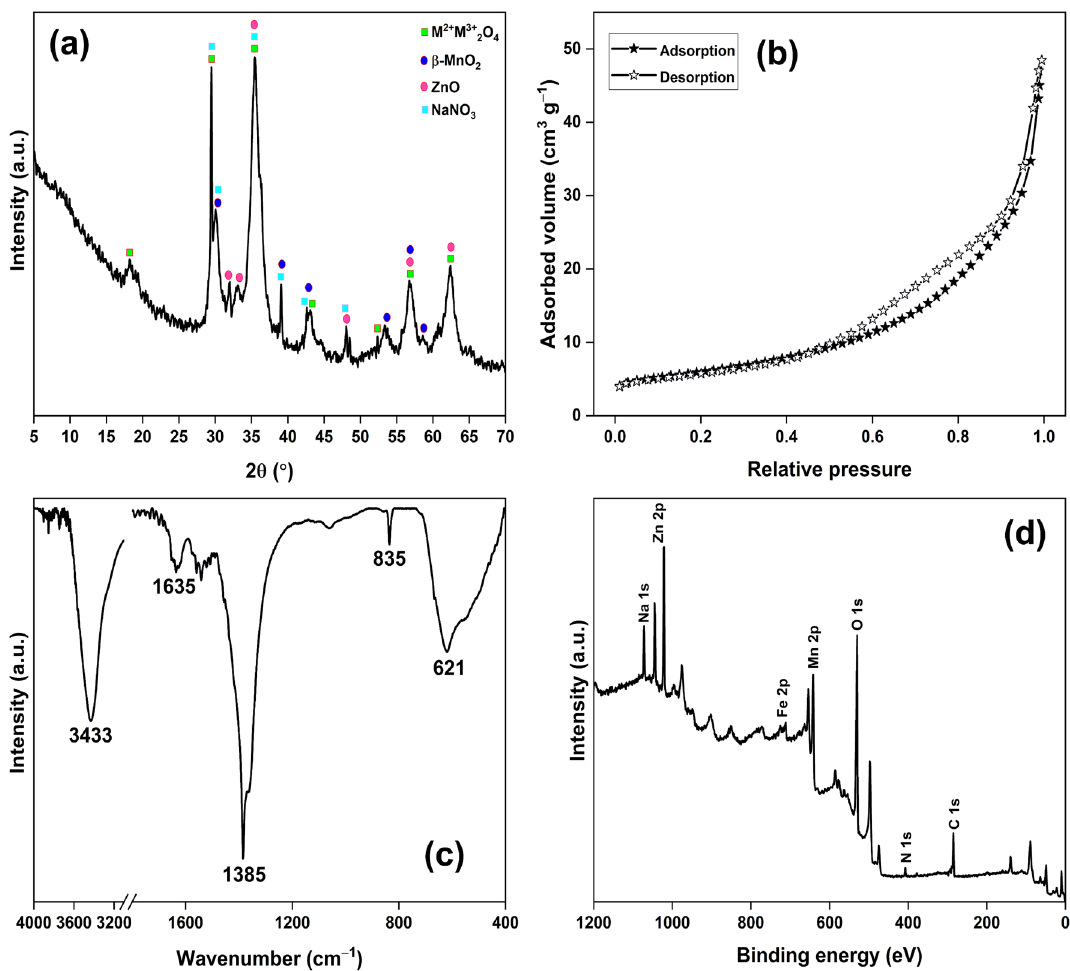
Figure 2. ( a ) PXRD pattern; ( b ) N 2 adsorption–desorption isotherm; ( c ) FTIR spectrum; ( d ) XPS survey of